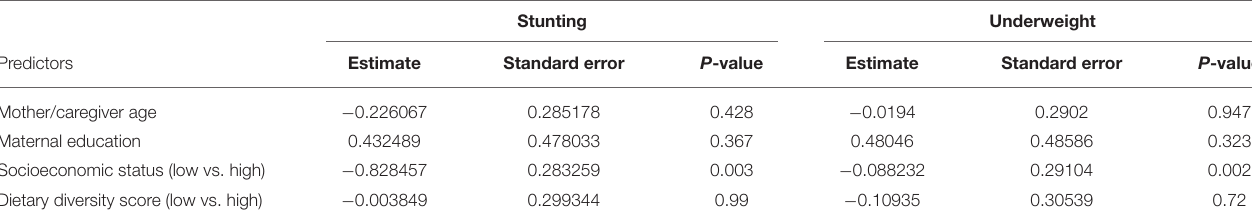
TABLE 4 | Multivariate analysis (logistic regression) of the association between a child’s stunted or wasted status and maternal education, mother or caregiver age, dietary diversity score, and socioeconomic status.